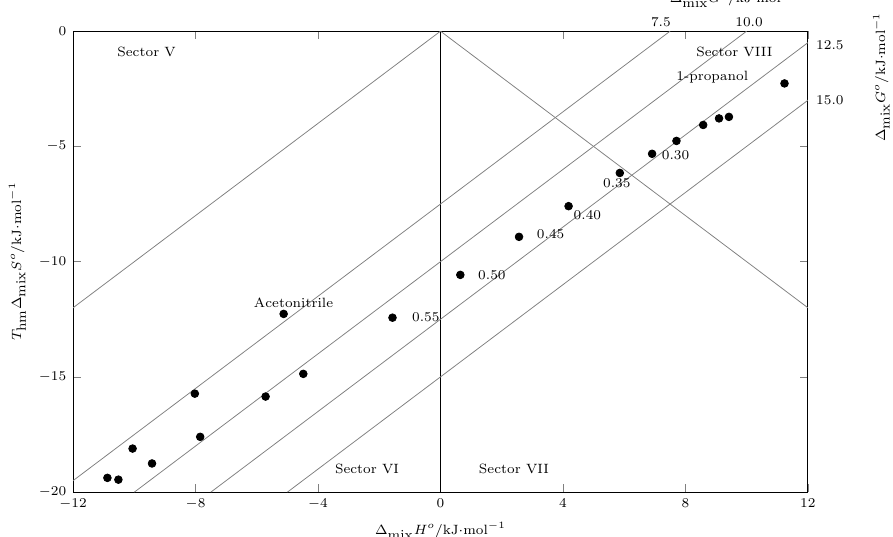
Figure 4. Relation between enthalpy ( ∆ mix H ◦ ) and entropy ( T hm ∆ mix S ◦ ) of the process mixing of sulfadiazine (3) in {MeCN (1) + 1-PrOH (2)} cosolvent mixtures at 297.6 K. The isoenergetic curves for ◦ are represented by dotted ∆ mix G